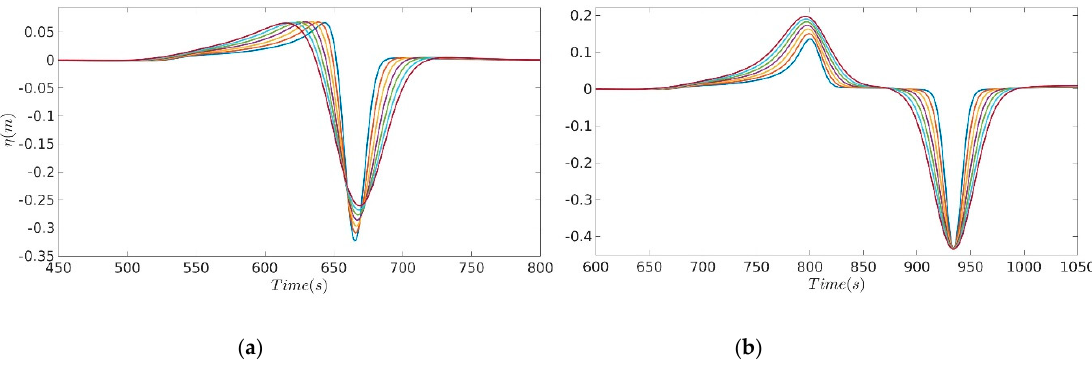
Figure 6. Waves generated by Gaussian-shaped wave group envelopes with different forcing length but with the same propagation speed. Each line represents a different group length, from shortest 200 m (blue line), to the longest 345 m (dark red). Shoaling zone ( a ) and horizontal plateau ( b ).